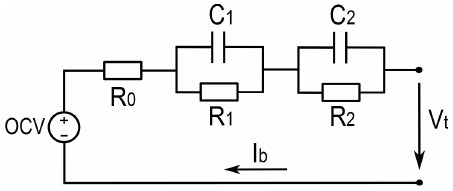
Figure 1. ECM with 2 RC